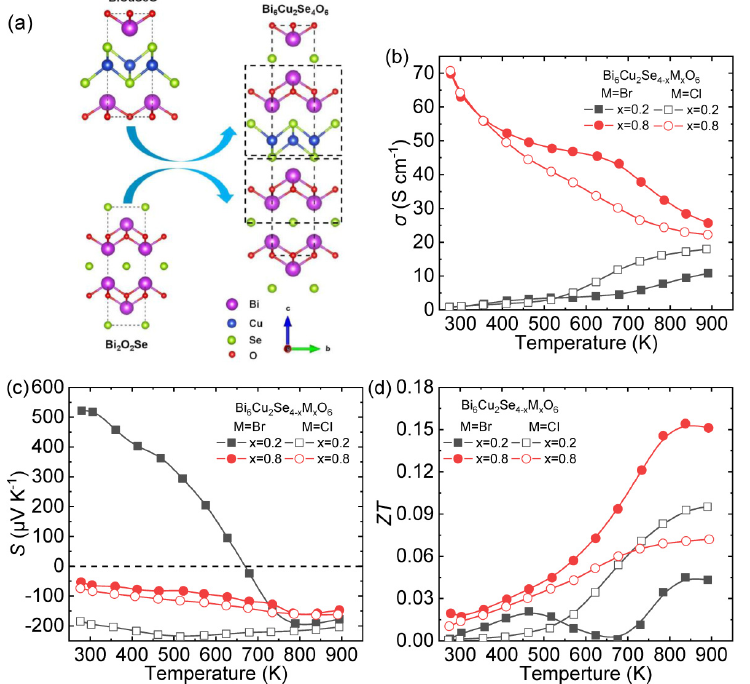
Figure 10. ( a ) The crystal structure of Bi 6 Cu 2 Se 4 O 6 . The temperature dependence of thermoelectric transport properties for Bi 6 Cu 2 Se 4 − x M x O 6 (M = Cl/Br, x = 0.2/0.8): ( b ) electrical conductivity, ( c ) Seebeck coefficient, ( d ) ZT . Data shown in ( b – d ) were adopted from Reference [ 29]. Copyright 2019, WILEY-VCH Verlag GmbH & Co. KGaA, Weinheim.